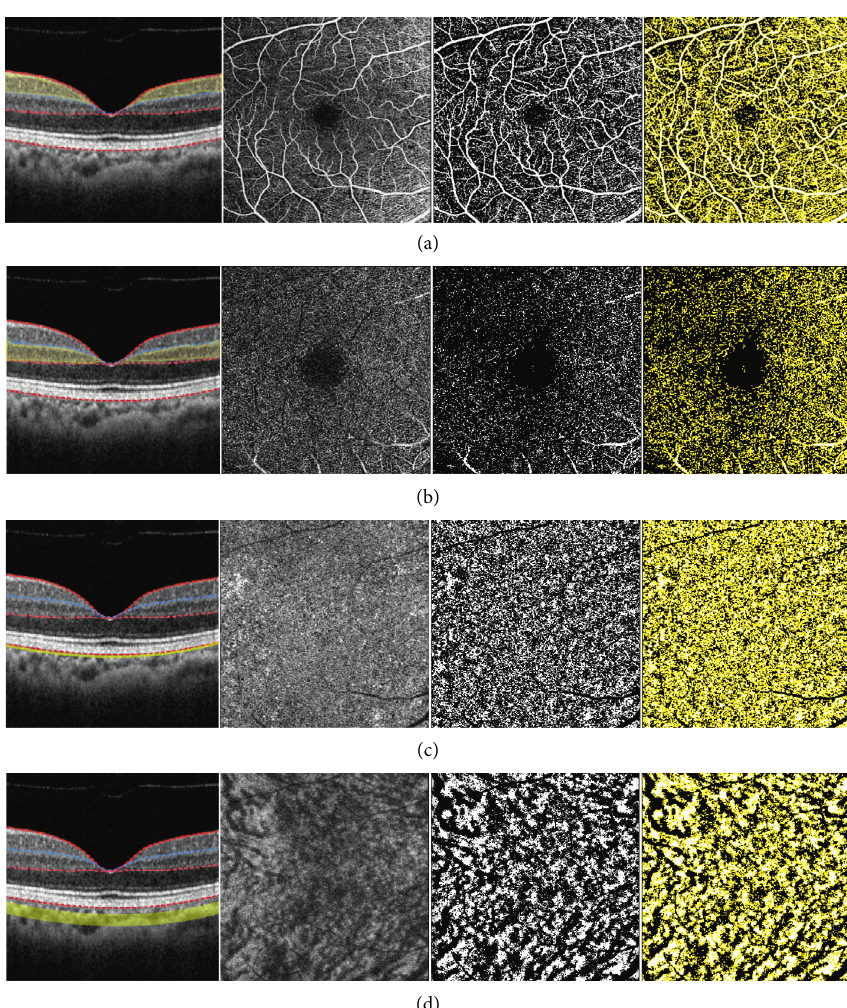
Figure 1: Vessel density measurements of each layer. En face 3 × 3mm2 optical coherence tomography angiography (OCTA) images of (a) superficial vascular complex (SVC), (b) deep vascular complex (DVC), (c) choriocapillaris, and (d) choroid were analyzed. Each slab was automatically obtained using predefined settings of the Spectralis OCTA system. SVC consisted of nerve fiber layer vascular plexus and superficial vascular plexus, and DVC consisted of intermediate capillary plexus and deep capillary plexus. Choriocapillaris slab is generated by segmentation of 10 to 30 μ m below Bruch’s membrane and choroid is defined as choroidal areas below the choriocapillaris up to chorioscleral junction (first and second column). Image binarization was performed using Niblack’s method with a 30 ° radius (third column). The white region was considered the vascular area in SVC, DVC, and choriocapillaris slabs and the black region was considered the vascular area in choroid slab (forth column). The number of pixels was obtained, and flow density was calculated by dividing the number of pixels of the vascular area by the total region of